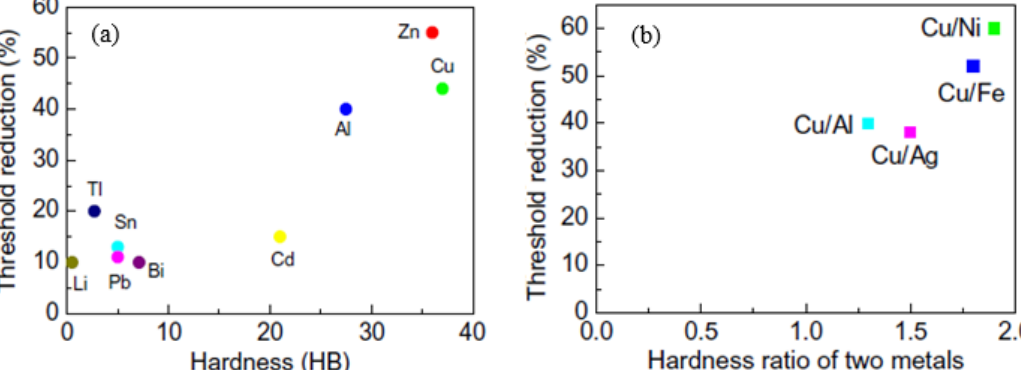
Figure 8. ( a ) Hardness and “ R t ” relationship for same metal CRB joints; and ( b ) hardness ratio and “ R t ” relationship in dissimilar metals CRB joints. Reproduced with permission from Ref. [11].